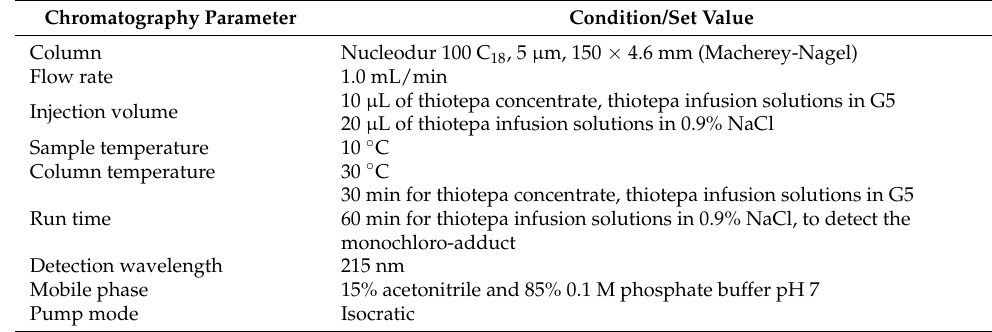
Table 1. Parameters of the RP-HPLC